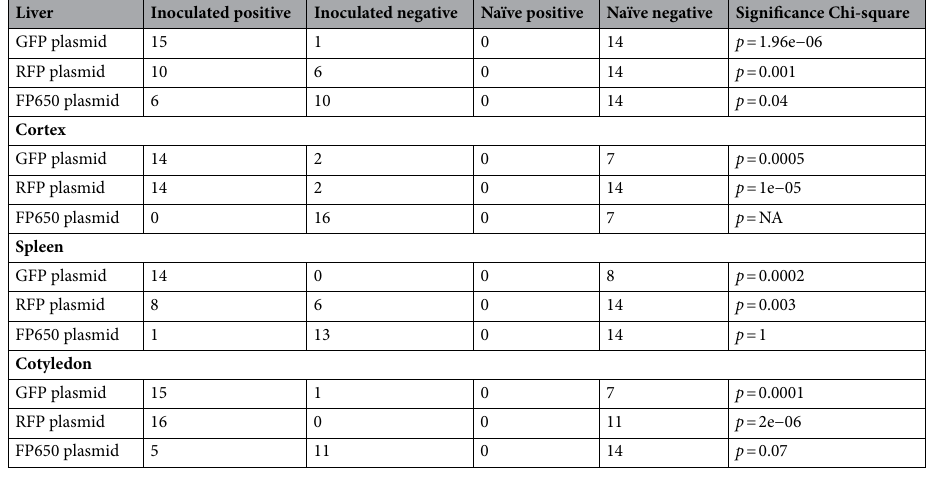
Table 2. PCR of fluorescent plasmids counted by presence of bands after gel electrophoresis. Chi-squared analysis to test for significant difference compared to naïve